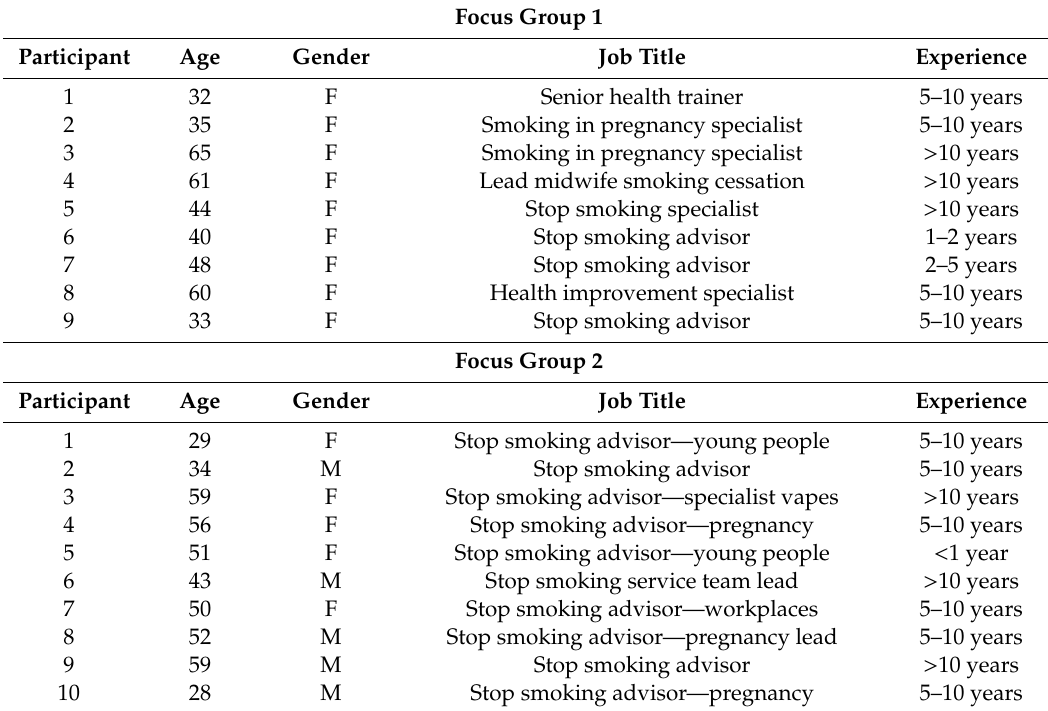
Table 1. Characteristics of focus group participants.